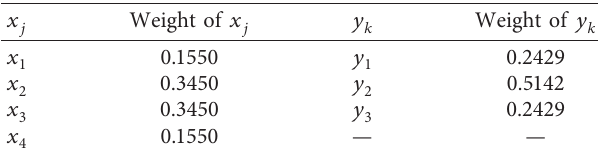
Table 7: Weight values.